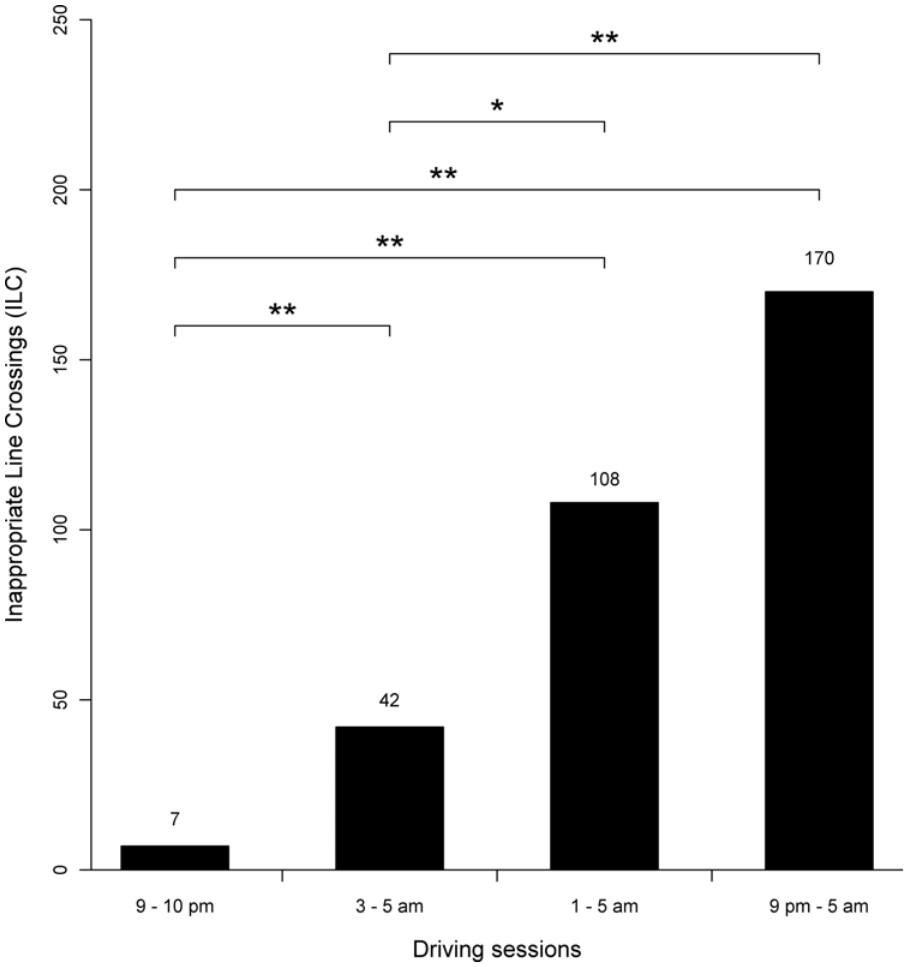
Figure 2. Cumulative number of inappropriate line crossings (ILC) for the 14 subjects in the last hour of the 3 nocturnal driving sessions (short, intermediate and long durations of driving), as well as the ILC for the reference drive (9–10 pm of the long drive). Statistical analyses refer to Incidence rate ratios (IRR) with 95% confidence intervals (CI) using the short drive and the 9–10 pm drive as reference (See section results). * P , .05. ** P , .001.